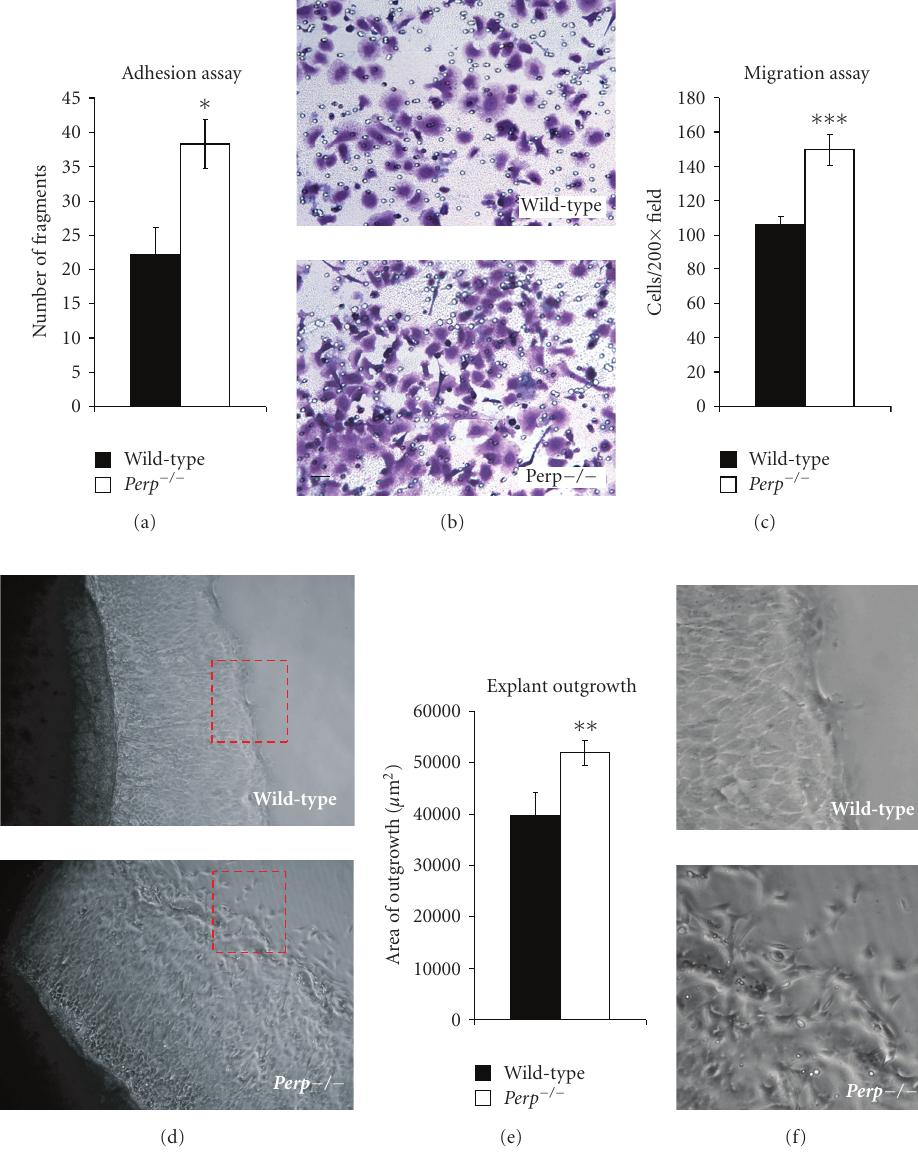
Figure 6: Perp − / − keratinocytes display enhanced migration capacity in vitro . (a) A mechanical dissociation assay was performed on wild- type and Perp − / − keratinocyte monolayers. The number of cellular fragments per 4 100 × fields was counted and averaged. Graphs show the average of three independent experiments performed in triplicate and error bars represent +/ − SEM. (b) A transwell migration assay was used to assess the migration potential of wild-type and Perp − / − keratinocytes. Representative image of migrated cells stained with crystal violet. (c) The number of cells migrated in each of 3 200 × fields was counted and averaged. The results represent the average of three individual experiments +/ − SEM. (d) Representative phase-contrast images of wild-type and Perp − / − explants. The red dashed boxes represent the area seen in (f). (e) The average areas of outgrowth after 10 days for wild-type and Perp − / − explants are quantified in the graph. Wild-type: n = 26. Perp − / − : n = 50. Error bars represent the SEM. (f) Enlarged phase-contrast images of the areas boxed in red in panel (d) showing wild-type and Perp − / − explants. Statistical significance was determined using a Student’s unpaired t -test ∗ = P < . 04, ∗∗ = P < . 03, ∗∗∗ = P < .